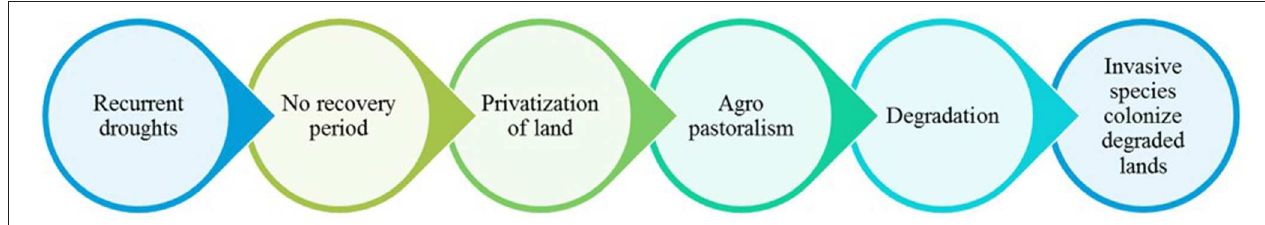
FIGURE 4 | Contextualizing interpretation of rangeland conditions.